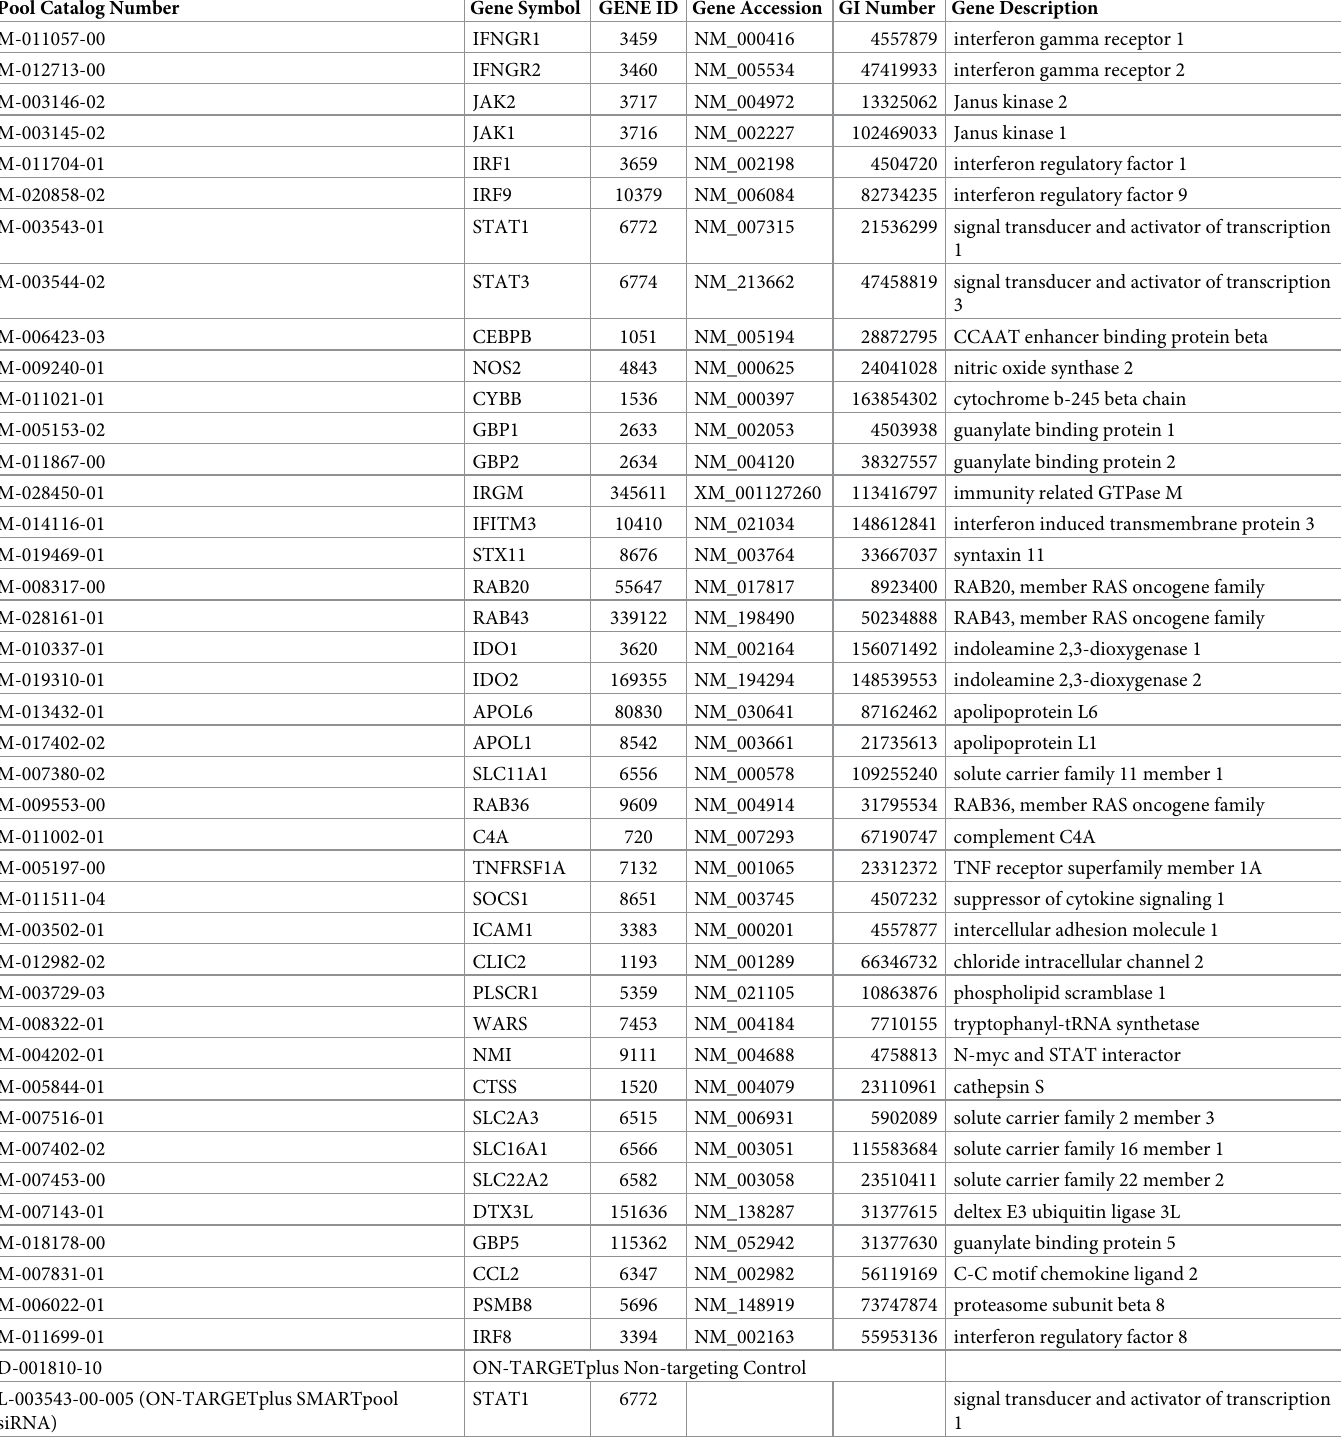
Table 2. SMARTpool siRNA from Dharmacon. Pool Catalog